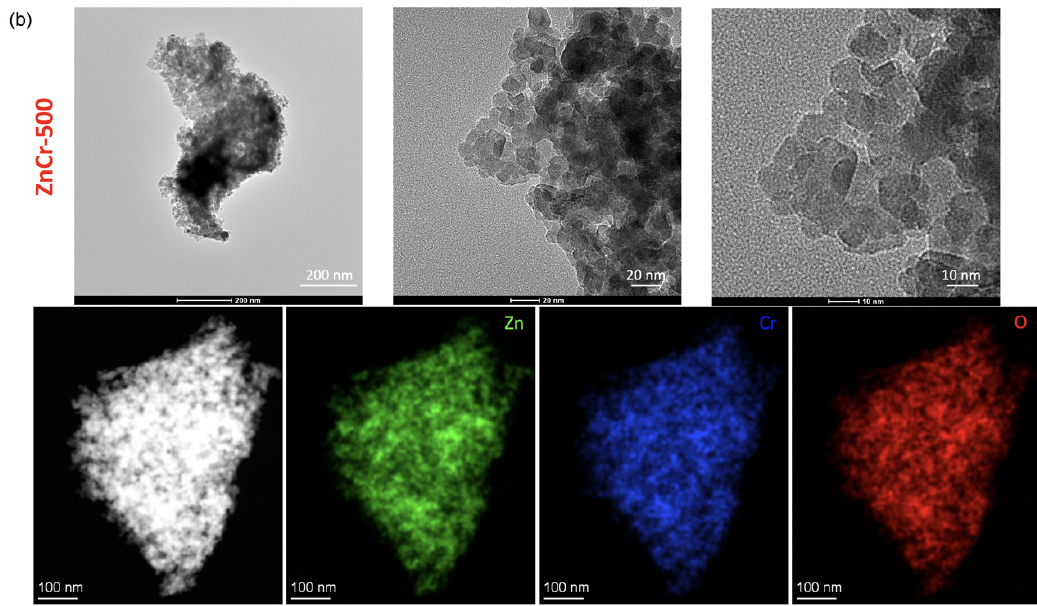
Figure 4. TEM images and EDX mapping of Zn, Cr and O elements for ZnCr-LDH ( a ) and ZnCr-500 ( b ) samples.